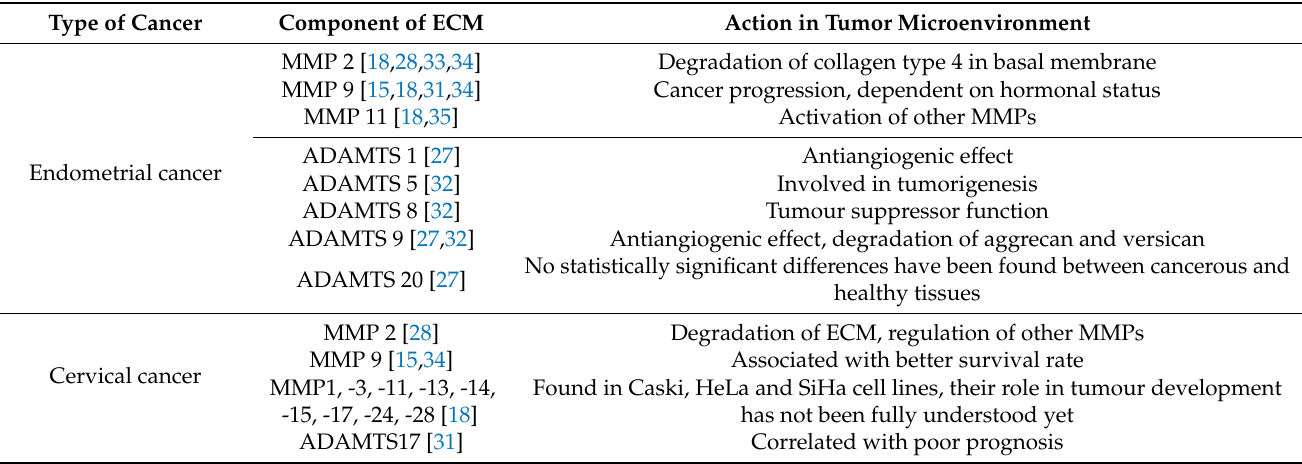
Table 1. Short overview of MMPs and ADAMTSs and their action in tumour